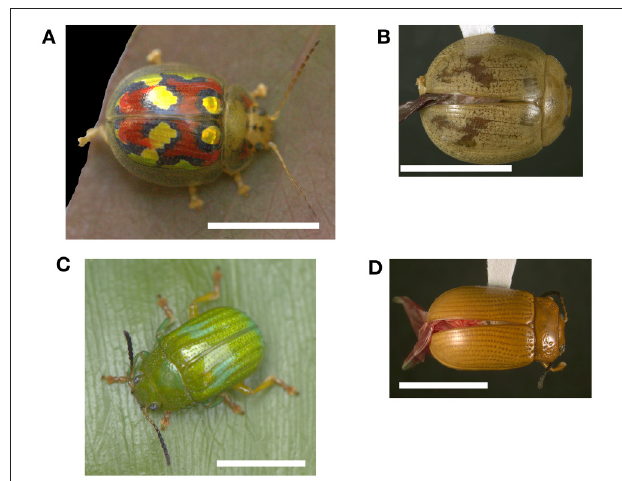
FIGURE 1 | Live and pinned specimens of chrysomelines. (A) Live specimen of an adult Paropsisterna gloriosa ; (B) Corresponding pinned specimen of Paropsisterna gloriosa (Image by Sue Lindsay, © Australian Museum); (C) Live specimen of an adult Calomela pallida ; (D) Corresponding pinned specimen of Calomela pallida (Image by Sue Lindsay, © Australian Museum). The white bars represent 5mm in each